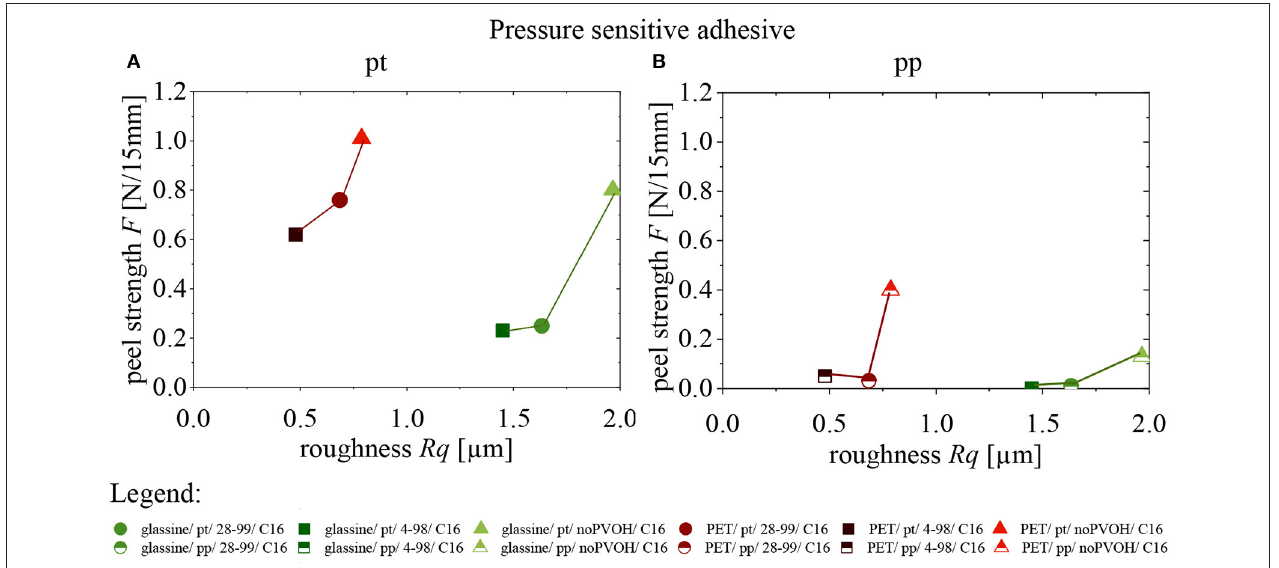
FIGURE 6 | Influence of substrate roughness on peel strength of two PSA (A) pt (B) pp. Lines are only added for clarity. n = 5.